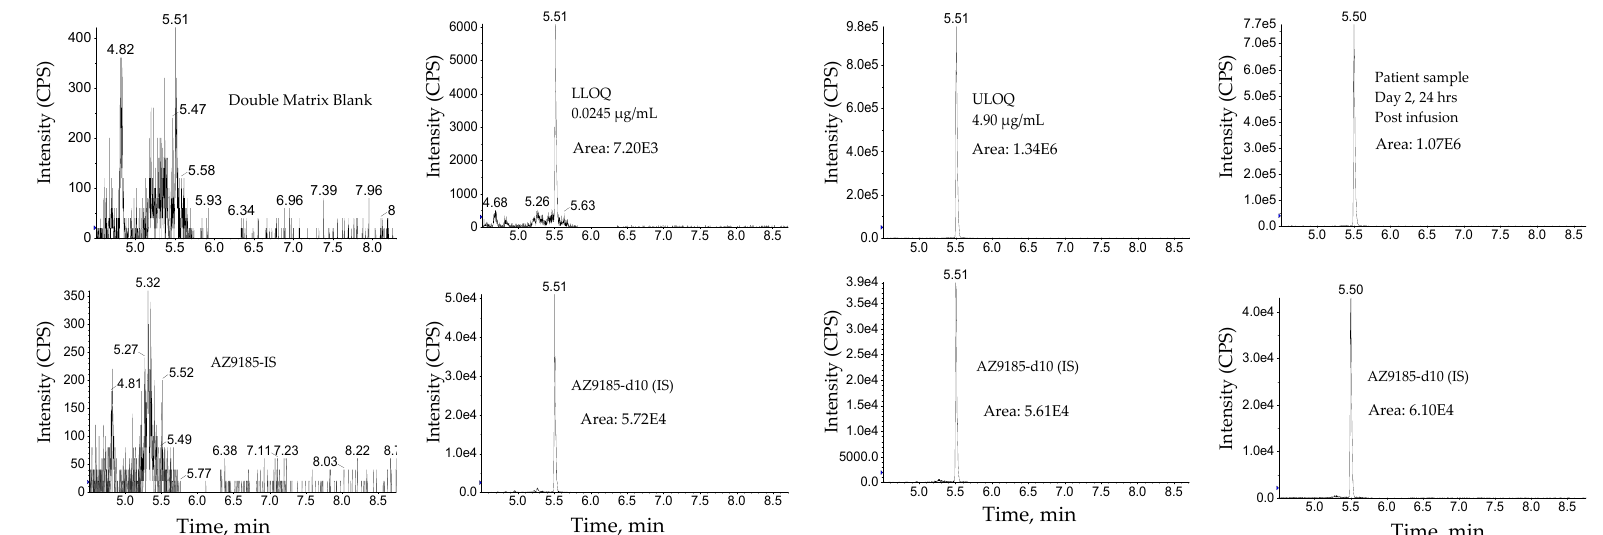
Figure 3. Representative chromatograms. ( A ) Total antibody assay using peptide SSQS (SSQSVFFR) as surrogate analyte. ( B ) Total antibody assay using peptide CLEW (CLEWVAR) as surrogate analyte. ( C ) Total ADC MEDI4276 using ac-AZ13599185 (AZ9185) as surrogate analyte. Peak areas were quantified using Analyst IntelliQuan processing algorithm with a smoothing factor of